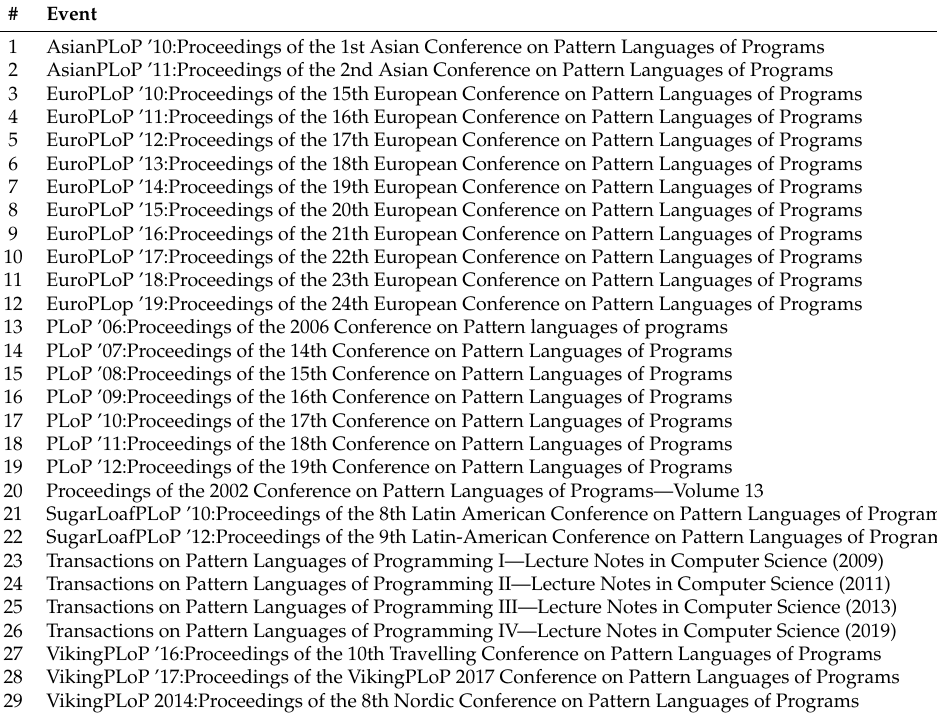
Table 3. Target venues for manual